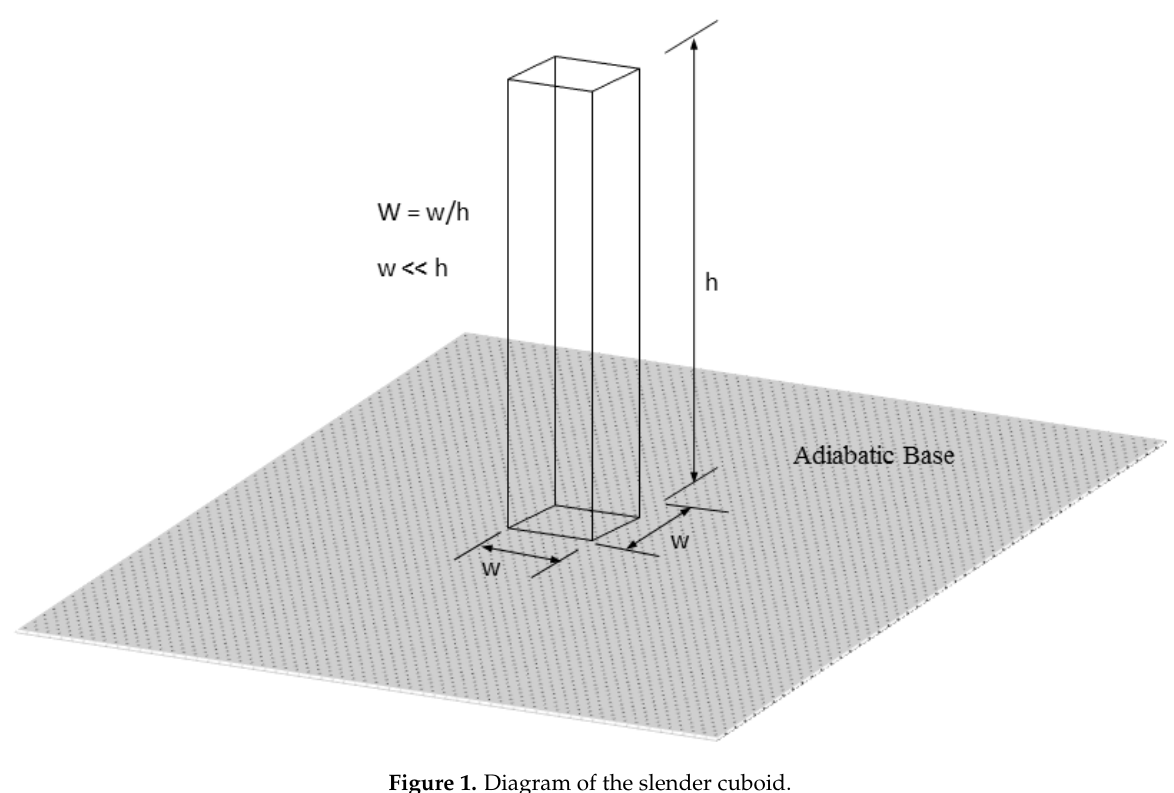
Figure 1. Diagram of the slender cuboid.